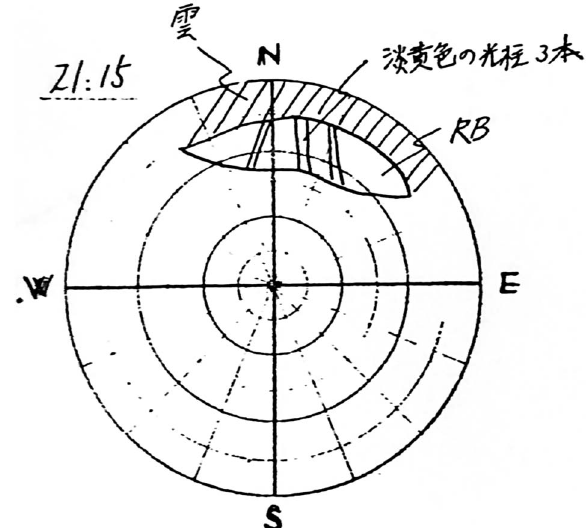
Fig. 3. Hand-made sketch of the red aurora at Abashiri Local Meteorological Of fi ce at 1215 UT on 11 February 1958 (after Japan Meteorological Agency, 1958). Information written in Japanese can be translated as follows: “ cloud ” (diagonal lines near the northern horizon); “ RB ” (ray-band) type bright dark-red aurora; with “ three light-yellow pillows ” .